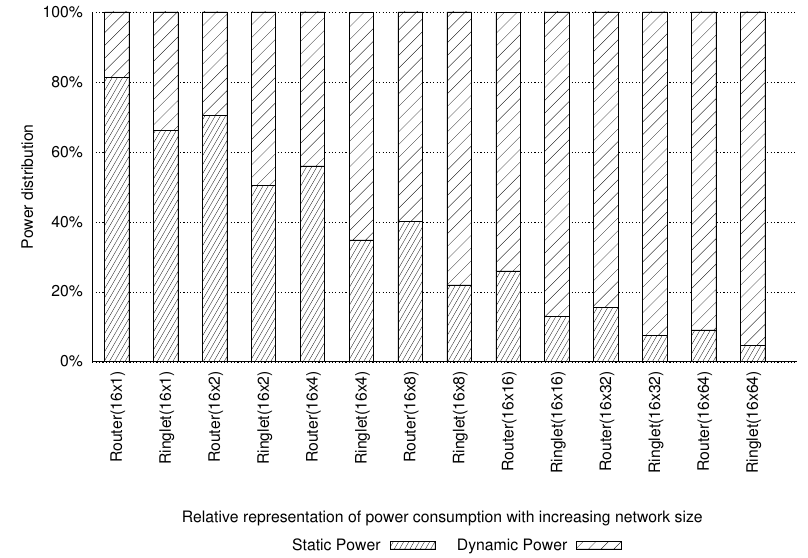
4 array of RSs (i.e., 4 ringlets). Red box ⇥